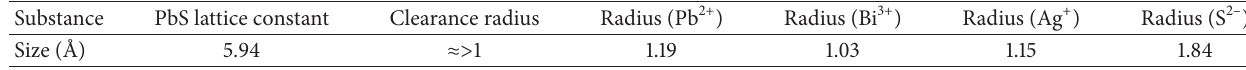
Table 6: Size parameters of each material in the PbS